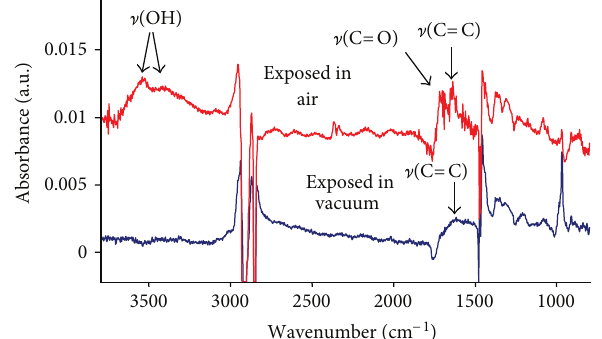
F 6: Differential FTIR ATR spectra of PIII-treated UHMWPE sample exposed to air and exposed to vacuum aer treatment. e PIII treatment time is 200sec for both samples. e sample without air contact does not have oxygen-containing groups in the surface layer. e spectra were recorded on single re�ection hemispherical ATR Germanium